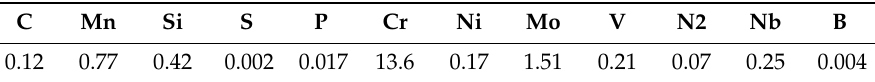
Table 1. Chemical composition (wt. %) (balance